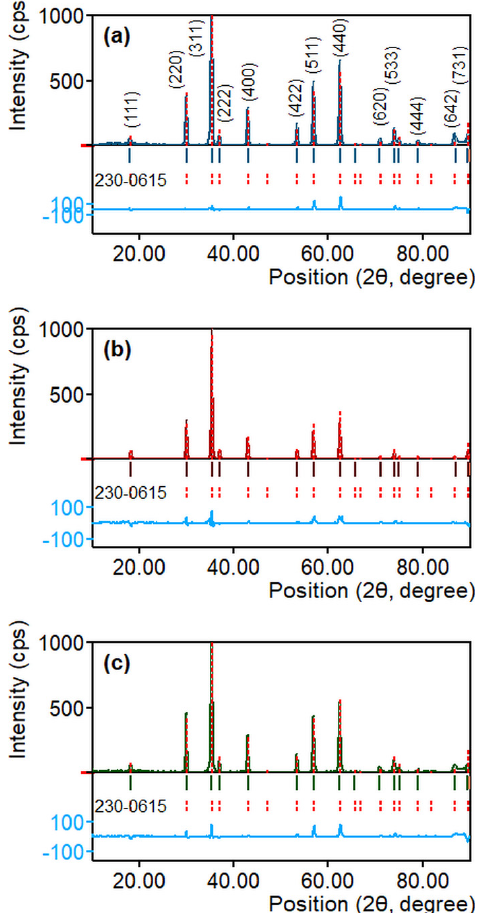
Figure 2. X-ray diffraction patterns of ZnFe 2 O 4 nanoparticles annealed at different temperatures: ( a ) Figure 2. X-ray di ff raction patterns of ZnFe 2 O 4 nanoparticles annealed at di ff erent temperatures: 600, ( b ) 800, and ( c ) 1000 °C. ( a ) 600, ( b ) 800, and ( c ) 1000 ◦